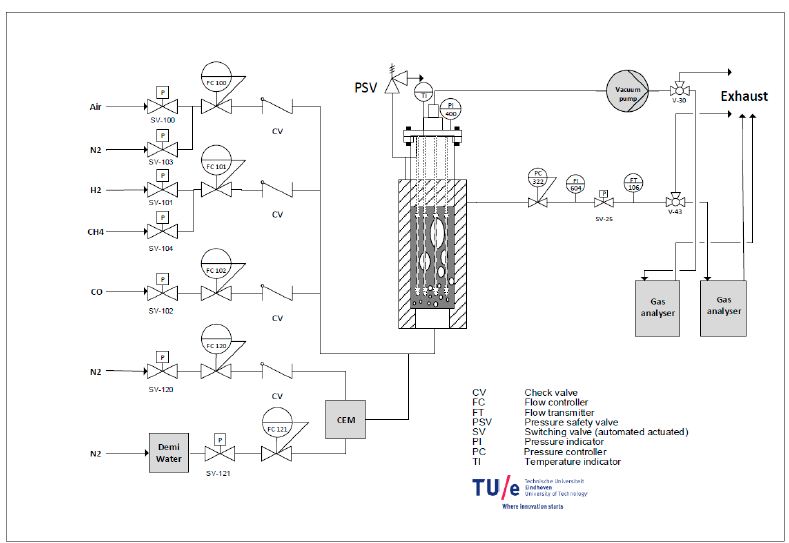
Figure 13. A process flow diagram of the membrane assisted fluidized bed setup. Molecules 2016 , 21 , 376